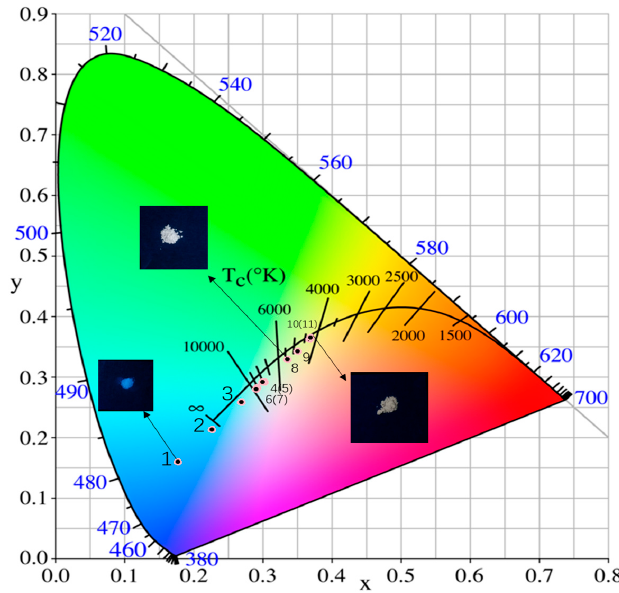
Figure 10. CIE 1931 color coordinates of Sr 2 Ca (1-1.5x%) WO 6 : x mol%Dy 3+ (x = 0, 0.1, 0.3, 0.5, 1.0, 1.5, 2.0, 3.0) and Sr 2 Ca 0.99 WO 6 :0.5 mol%Dy 3+ , 0.5 mol% M + (M + = Li + , Na + or K + ) .